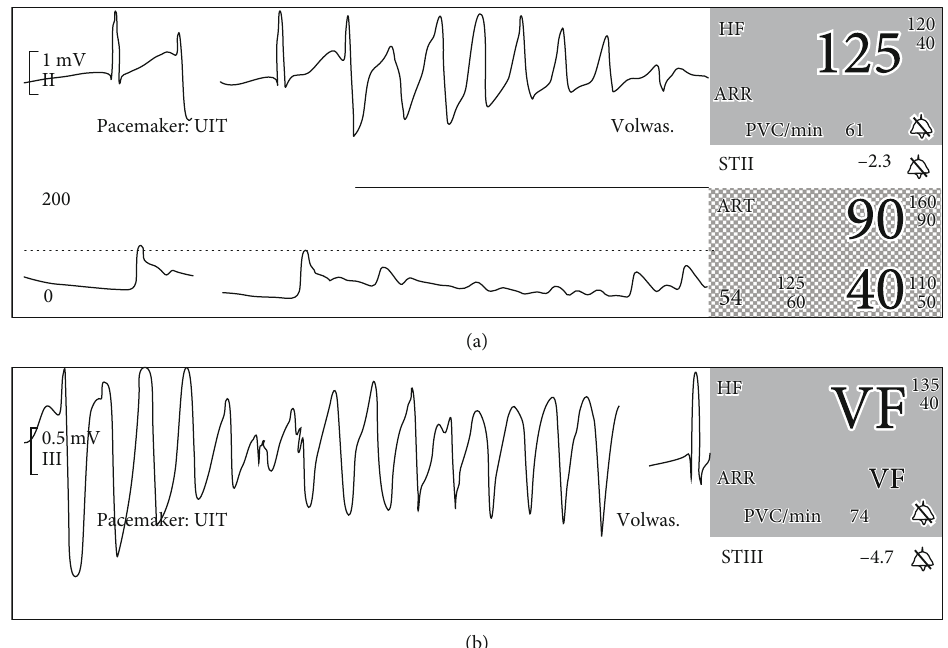
Figure 1: Two screenshots of bedside cardiac monitoring at admission: (a) a run of ventricular tachycardia and (b) a short episode of ventricular fi brillation.